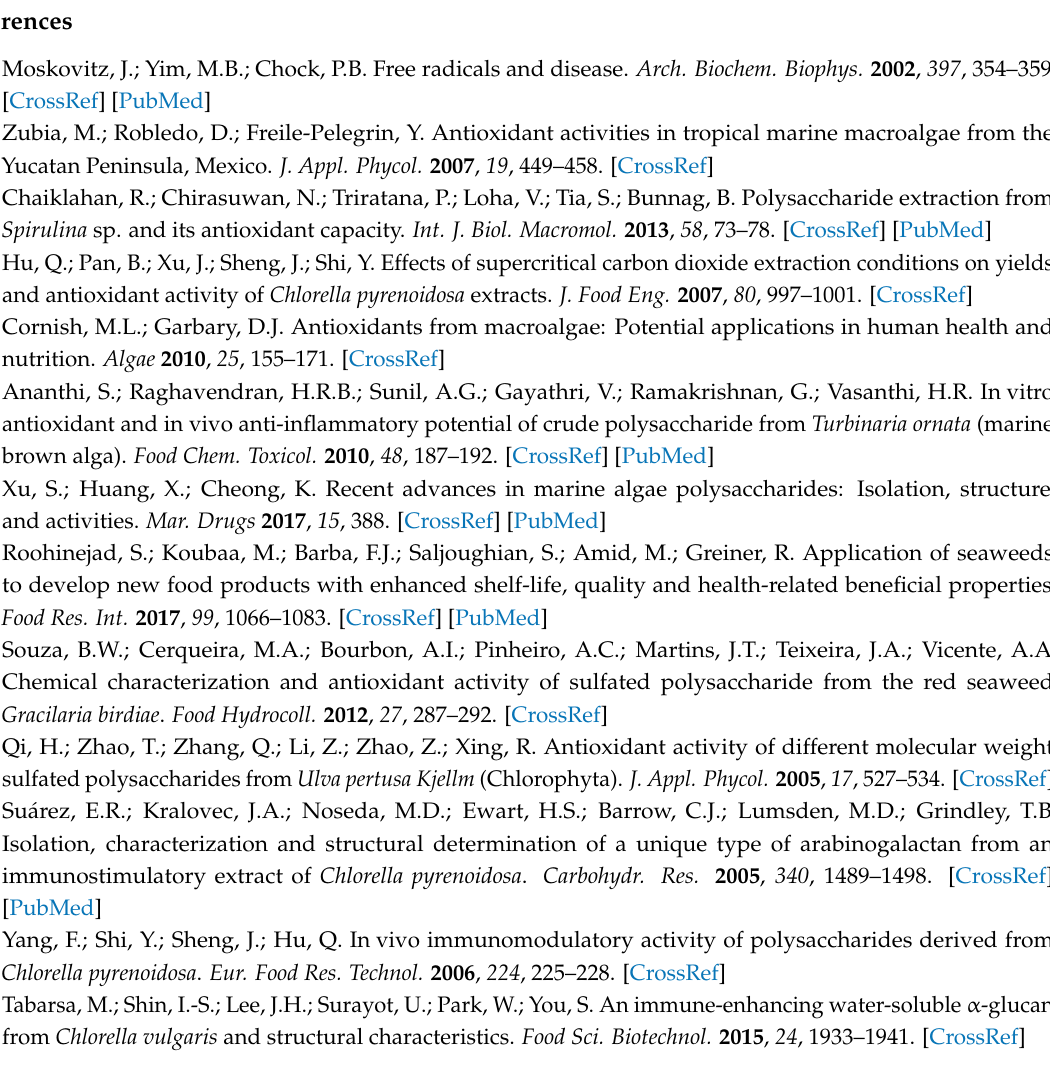
Figure S1: Standard curve for determination of sulfate group content in microalgae polysaccharides by BaCl2- gelatin method. Regression equation is: Y = 0.31416x + 0.04545, R = 0.99647, Figure S2: UV-VIS spectrum of P-IIa, Table S1: ANOVA of the experimental results of the